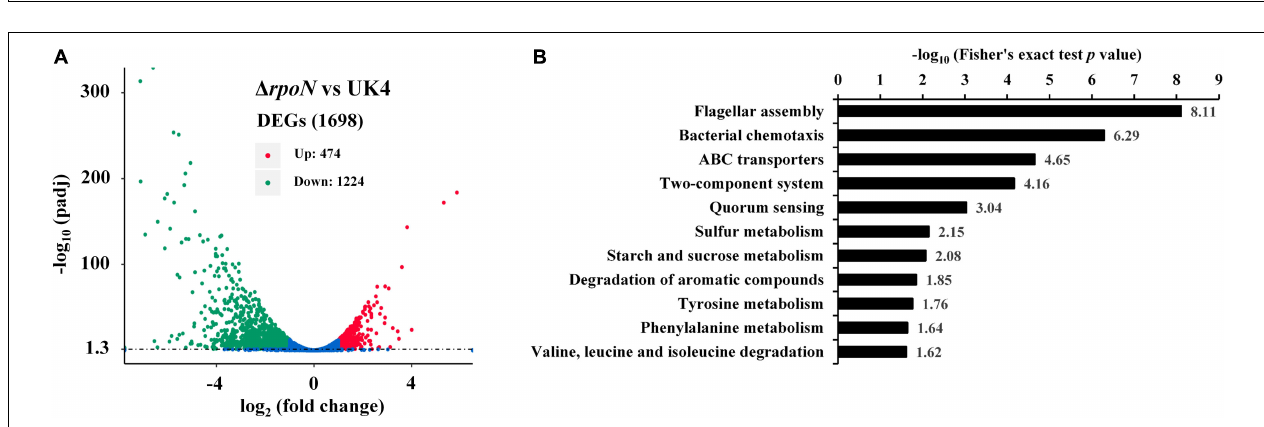
FIGURE 5 | Sensory assessment (A) , TVC (B) , extracellular protease activity (C) , and TVB-N (D) of P . fluorescens wild-type strain UK4 and the mutant strain (cid:49) rpoN in sterilized fish juice stored at 4 ◦ C. Data are expressed as mean ± SD of three independent experiments.